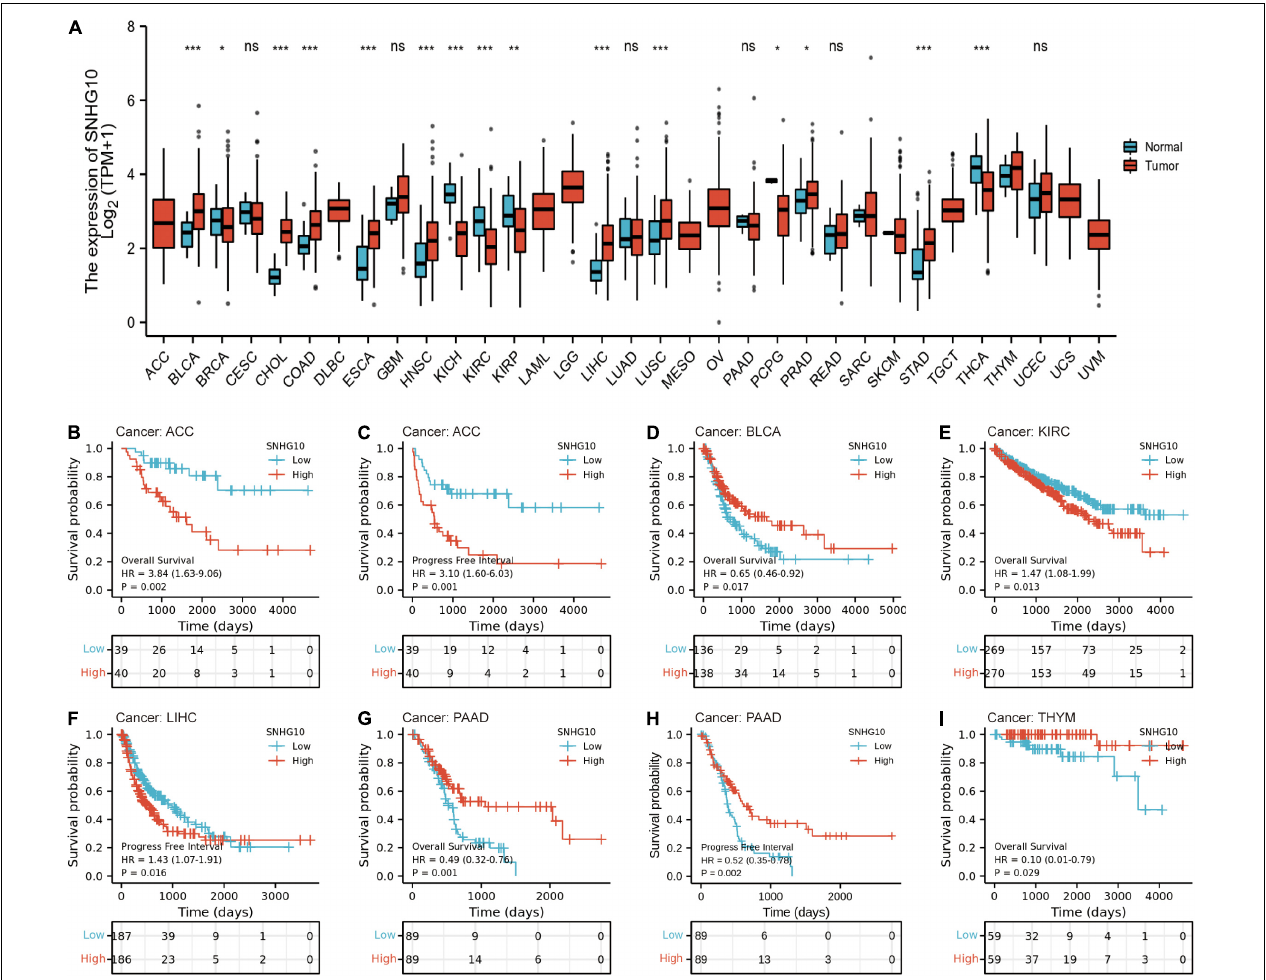
FIGURE 4 | SNHG10 expression and prognosis in patients with other cancer types. (A) Differences in expression of SNHG10 in normal and tumor tissues of TCGA. (B–I) Kaplan-Meier curves were drawn to evaluate the prognostic value of SNHG10 in OS or PFS of other cancers. * P < 0.05, ** P < 0.01, and *** P <